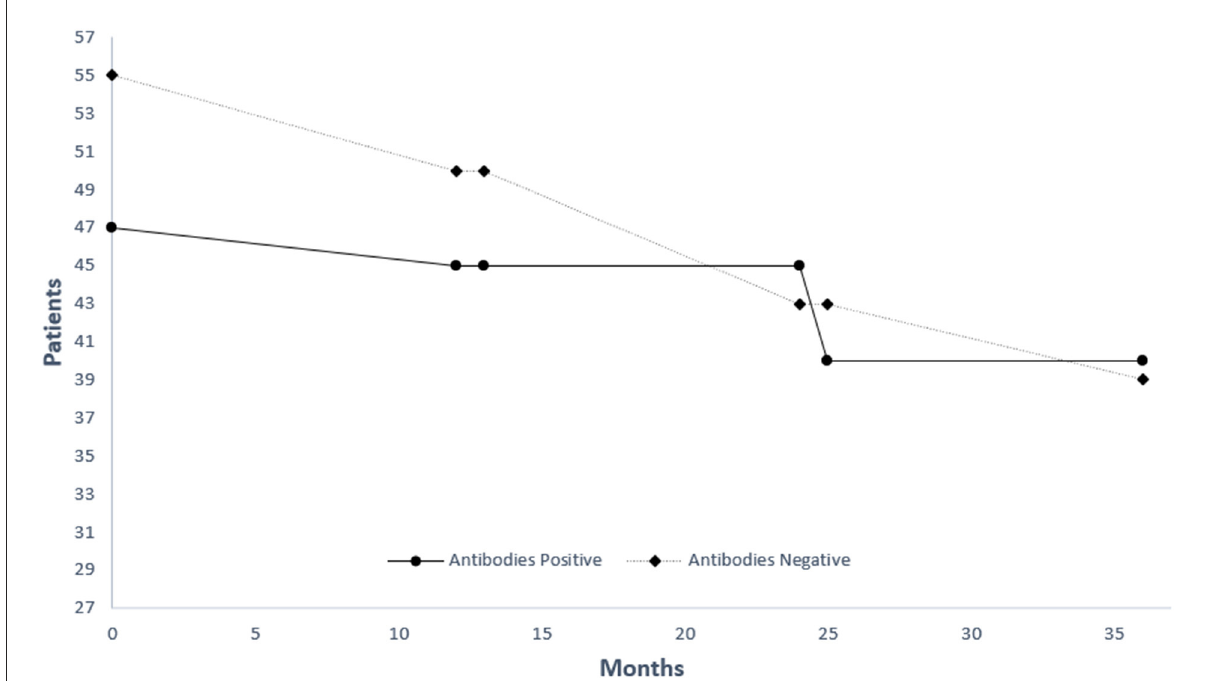
FIGURE1 Kaplan-Meier estimate of survival for patients with (black line) and without (grey line) antibodies.